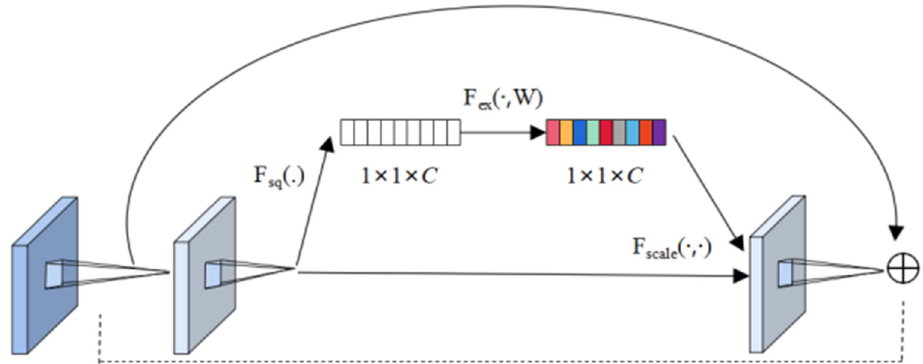
Figure 5. Structure of SENet.